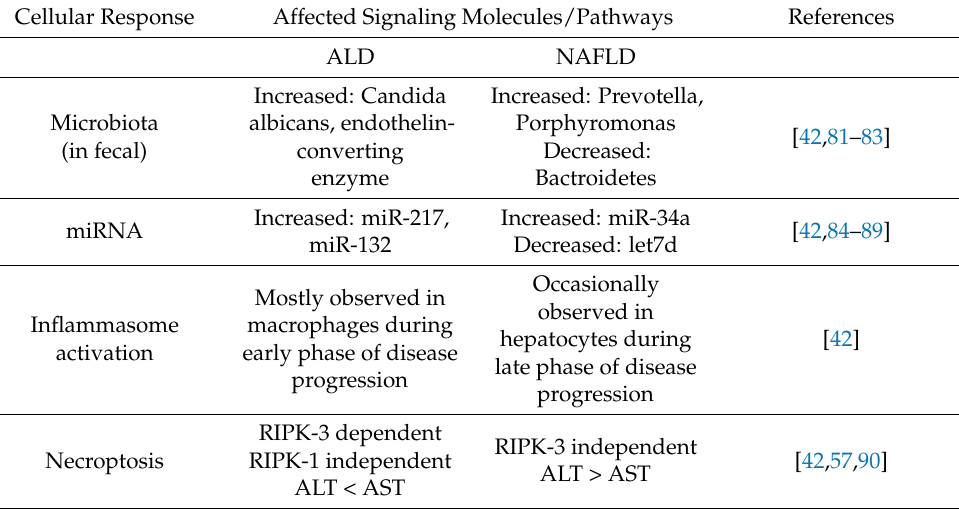
Table 1. Cont. Differences: Distinct Signaling Pathways/Molecules between ALD and NAFLD Cellular